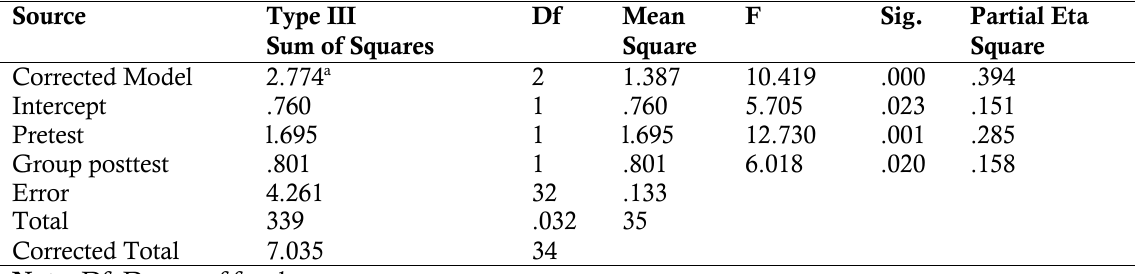
Table 2: Summary of ANCOV A on the perceived impact of mentoring programme on job satisfaction